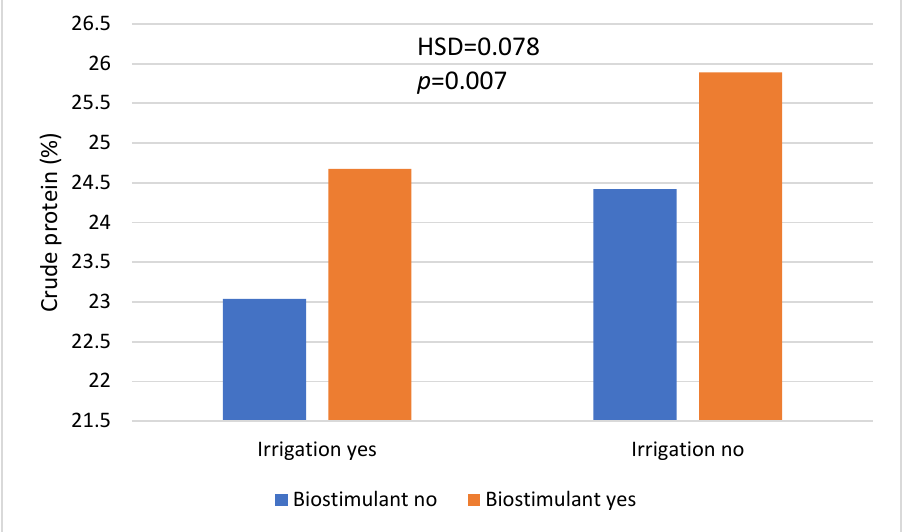
Figure 2. Crude protein content in pea seeds after application of irrigation and biostimulant. HSD, honestly significant differences.